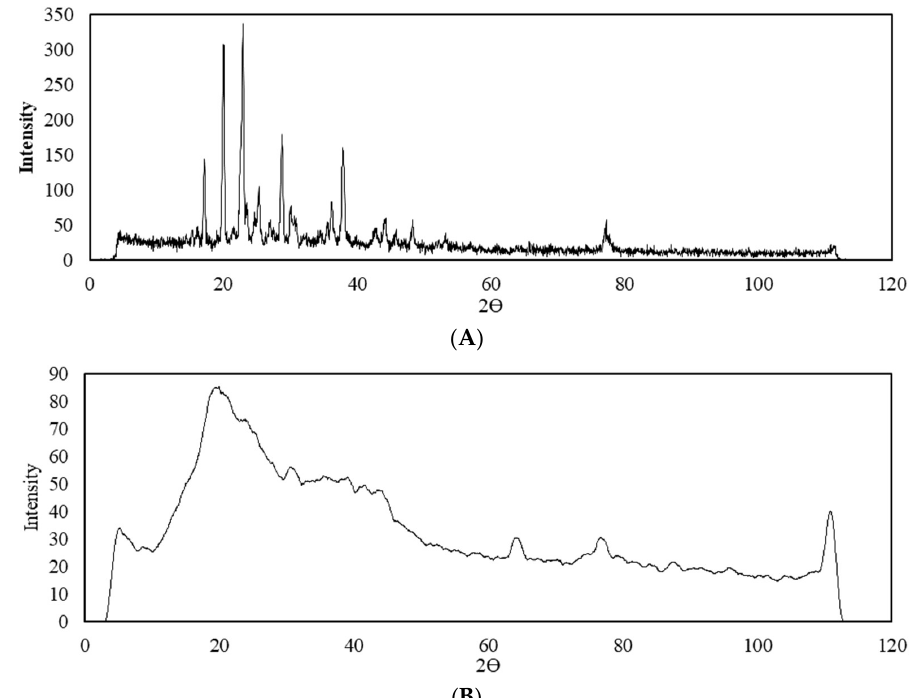
Figure 4. X-ray diffraction patterns: ( A )—crystalline clomipramine; ( B )—clomipramine-loaded protein aerogel.